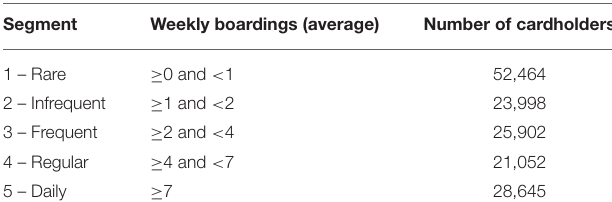
TABLE 1 | Bus use frequency segments.